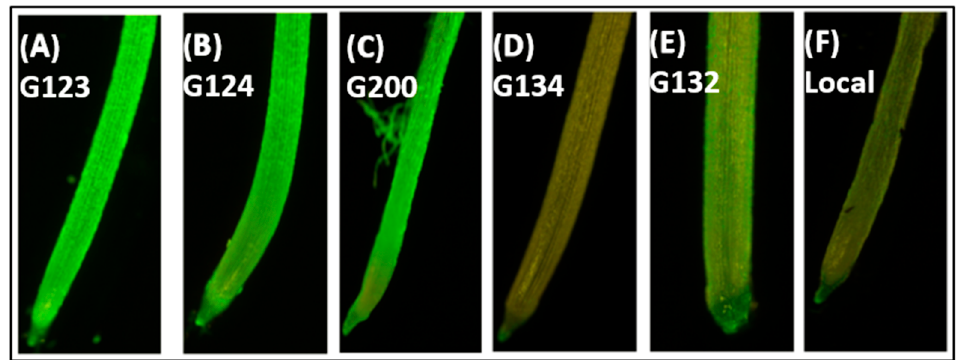
Figure 5. Effect of different salinity levels on ROS accumulation in the apical meristem of 8-day-old barley genotypes. The seedlings grown in the magenta box and roots were stained using H2DCFDA.